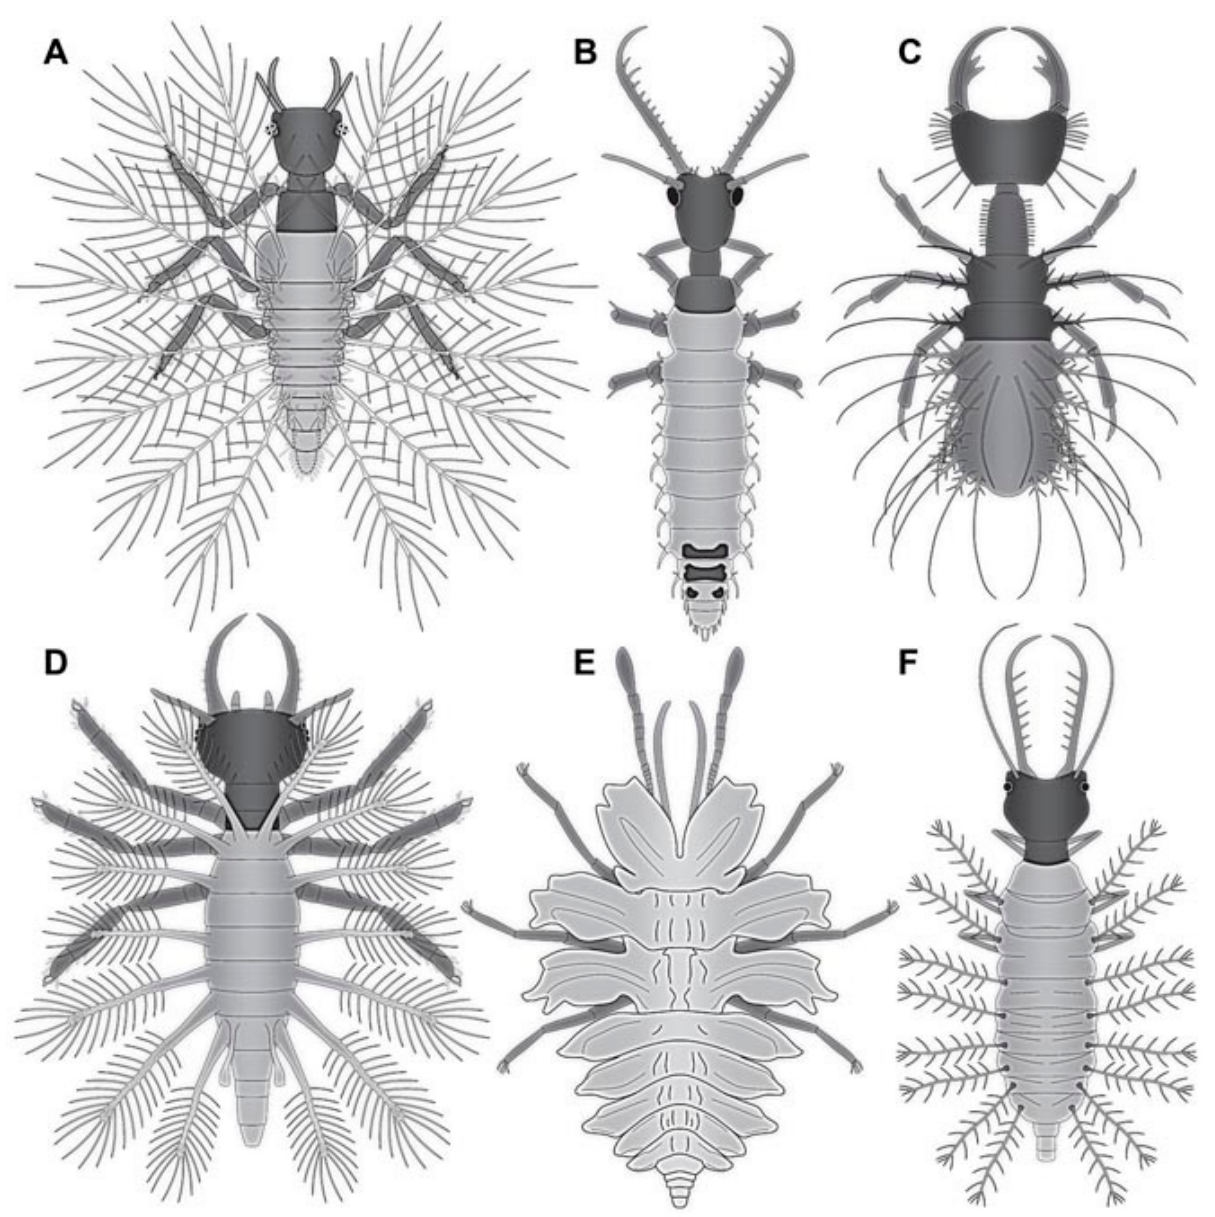
Figure 56. Different lacewing larvae with processes or other structures used for disguising themselves, not to scale. ( A ) Tyruschrysa melqart based on Pérez-de la Fuente et al. [9] with long processes similar to type 1. ( B ) Superfang larva from Haug et al. [18] with short processes similar to type 4. ( C ) Electrocaptivus xui based on Badano et al. [14] with proximally branched processes. ( D ) Tragichrysa ovoruptora based on Pérez-de la Fuente et al. [10] with long processes similar to type 1. ( E ) Phyllochrysa huangi based on Liu et al. [13] imitating a liverwort. ( F ) Cladofer huangi based on Badano et al. [14] with short-branched processes.